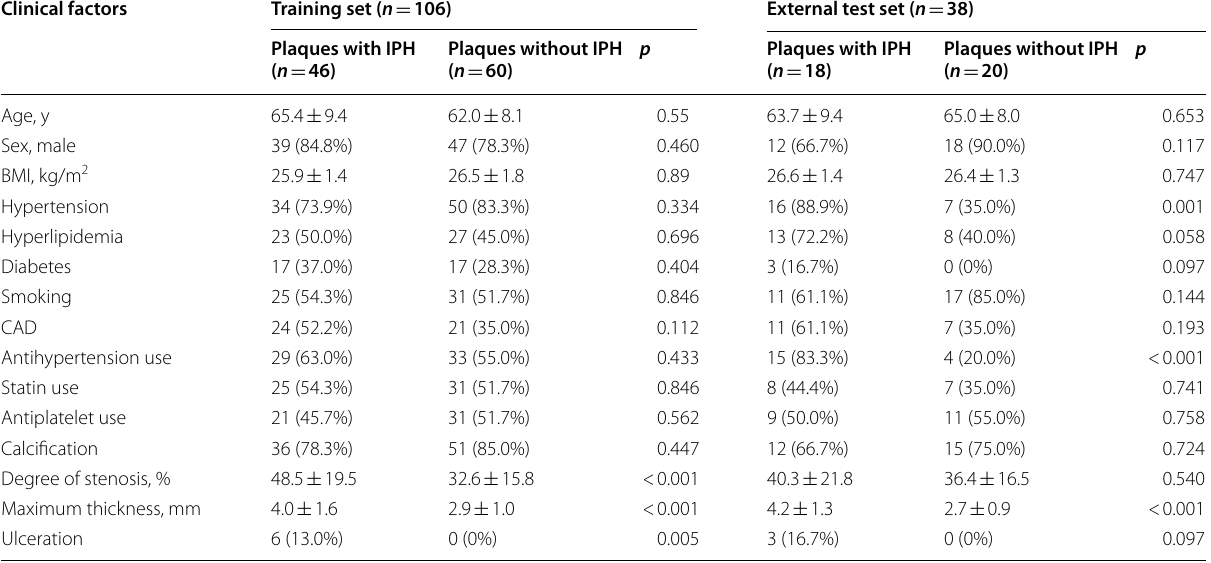
Continuous variables are described as mean standard deviation, and categorical variables are presented as numbers (%) ± BMI Body mass index, CAD Coronary artery disease, IPH Intraplaque